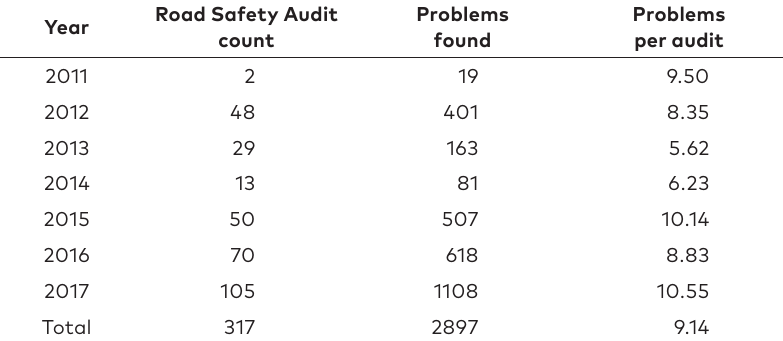
Table 1. Distribution of Road Safety Audit count and problems